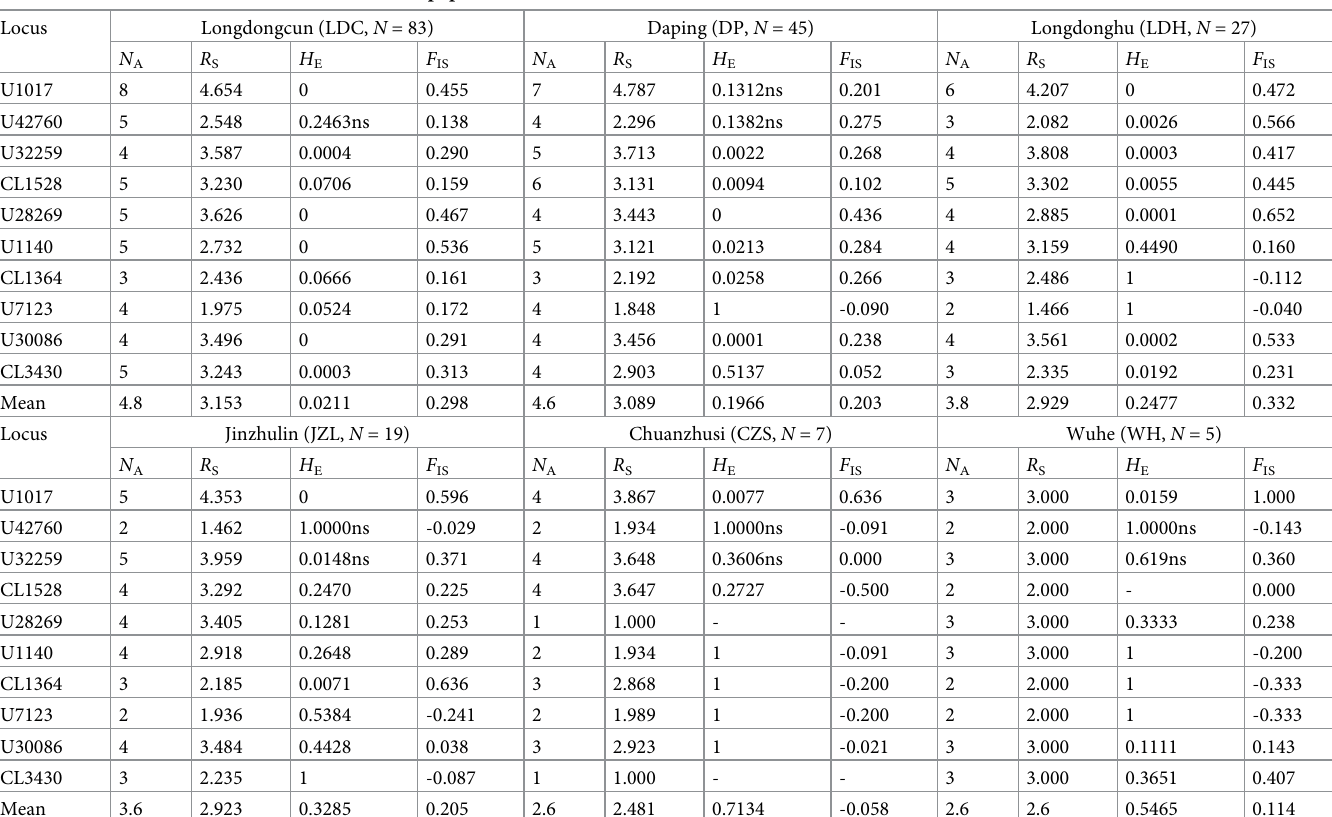
Table 3. Characteristics of the 10 EST-SSRs in each population of A . emeiensis